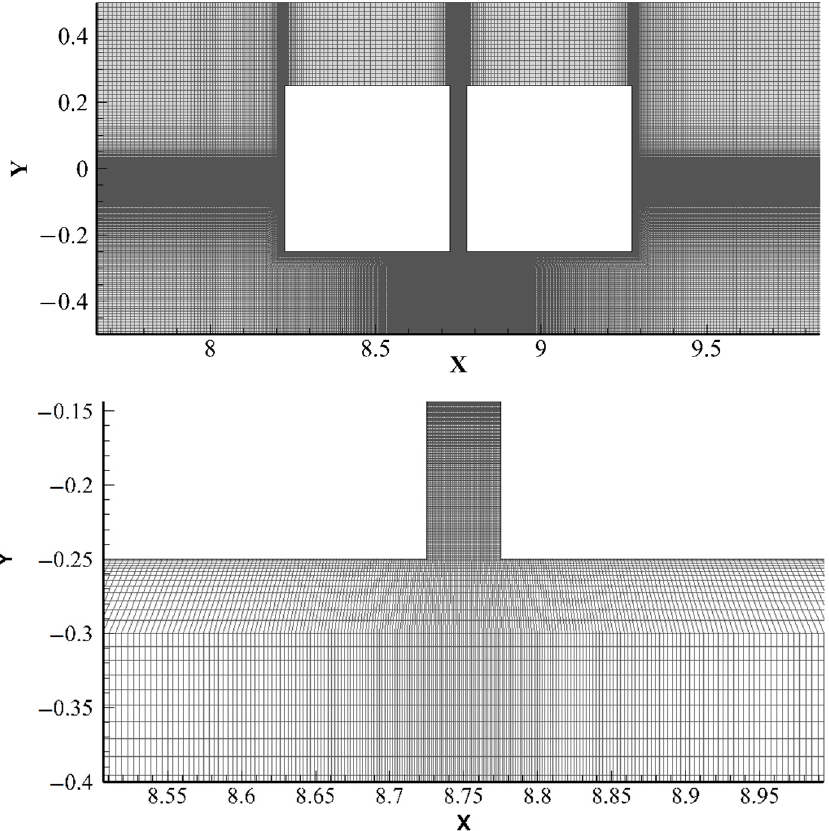
Figure 3. The zoom-in view of mesh around the twin squares for case C6. Table 2. The three different grid resolutions used in the present study.